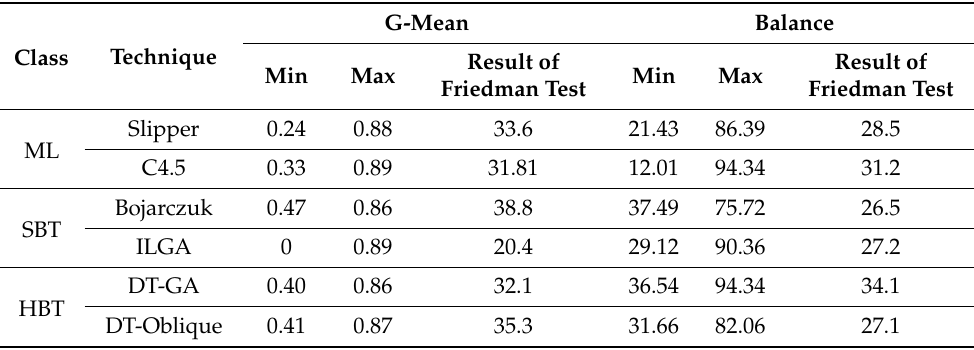
Table 1. Relative Performance of SDP